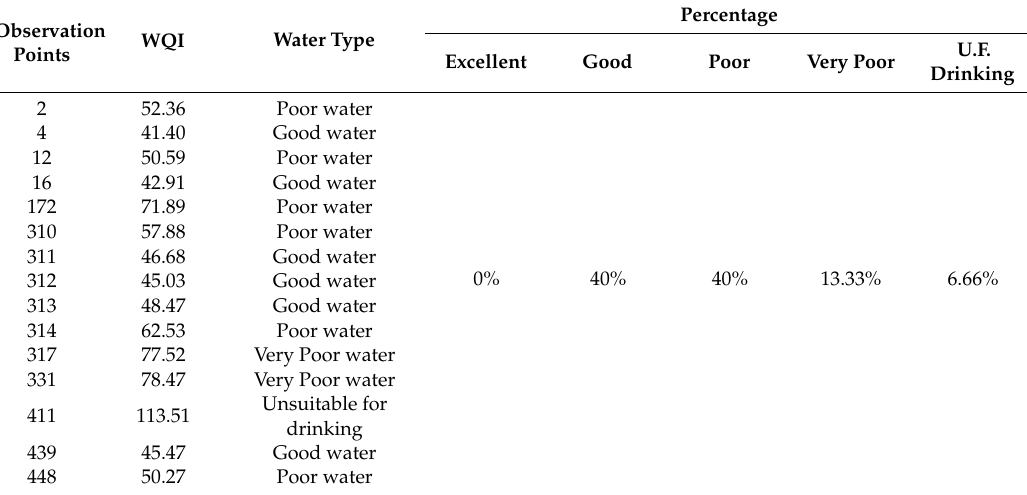
Table 10. Types of water and percentage of water condition in study